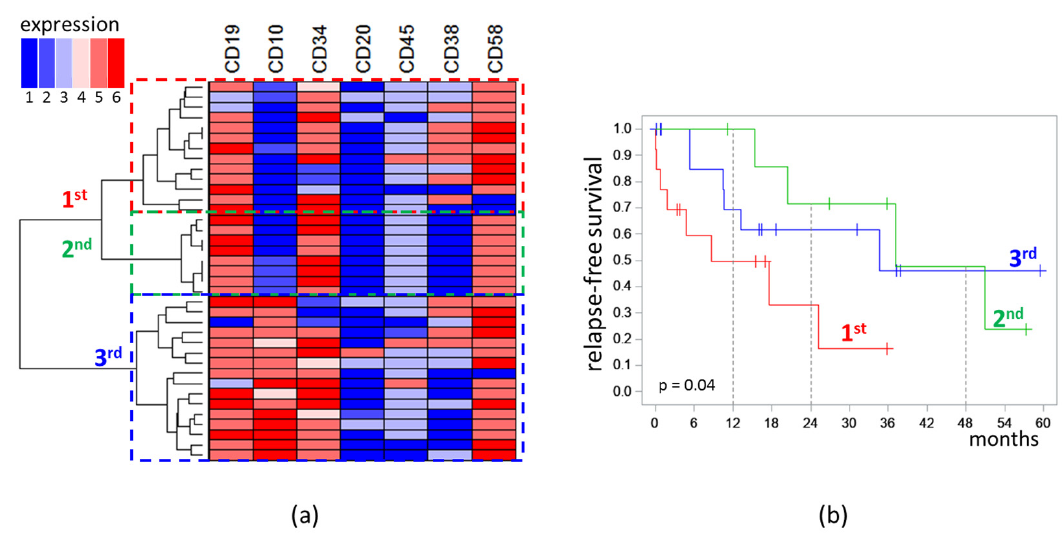
Figure 4. Analysis of immunophenotype of measurable residual blast cells detected at the end of induction: ( a ) Dendrogram and heat map of semiquantitative immunophenotype description (1: “ − ”; 2: “ − /+”; 3: “dim”; 4: “+/ − ”; 5: “+”; 6: “high”); ( b ) relapse-free survival depending on belonging to the clusters highlighted on the dendrogram. The initial date was the end of induction.